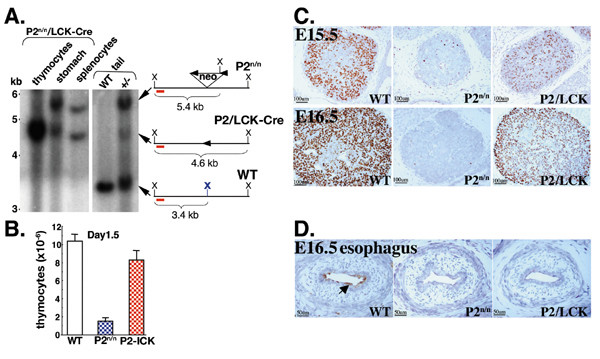
Rescue of P2neo/neo dependent thymic defect by T-cell specific removal of the neo cassette. (A) Specific excision of the neo cassette in P2/Lck-Cre mice. Southern blot analysis using a probe spanning the region indicated by the red bar assessed the level of neo excision in thymocytes, stomach epithelium and splenocytes of 4 week-old P2/Lck-Cre mice. The positions of XbaI cleavage sites are shown (X). The probe hybridized to a 3.4 Kb- and a 5.4 Kb XbaI genomic fragments derived from WT and P2neo/neo allele, respectively. Insertion/excision of the neo cassette by Lck-Cre eliminated the middle XbaI site (shown in WT as bold blue) generating the 4.6 Kb fragment derived from the P2/Lck-Cre allele. (B) Regeneration of thymus cellularity in P2/Lck-Cre mice. At day-1.5 the number of thymocytes in P2/Lck-Cre thymic lobes was near normal compared to WT littermates. Data shown are average ± S.E. of five independent experiments using five mice of each genotype (WT, P2neo/neo and P2/Lck-Cre). The difference between WT and P2neo/neo is significant at P < 0.001 by Student's t test. (C) Recovery of thymopoiesis and thymic organogenesis in P2/Lck-Cre embryos. Histological analysis and Runx1 expression in thymic lobes derived from E15.5 and E16.5 WT, P2neo/neo and P2/Lck-Cre embryos. Shown are H&E stained transverse sections immunostained for Runx1. (D) Runx1 expression was not rescued in P2/Lck-Cre epithelial cells. IHC analysis of Runx1 expression in esophagi derived from E16.5 WT, P2neo/neo and P2/Lck-Cre embryos. Transverse sections showing Runx1 expression in epithelial cells lining the lumen of WT (arrow), but not of P2neo/neo or P2/Lck-Cre esophagus. Several other tissues including stomach and nasal cavity were similarly analyzed and revealed no expression of Runx1 in epithelia of P2neo/neo or P2/Lck-Cre mice (not shown).